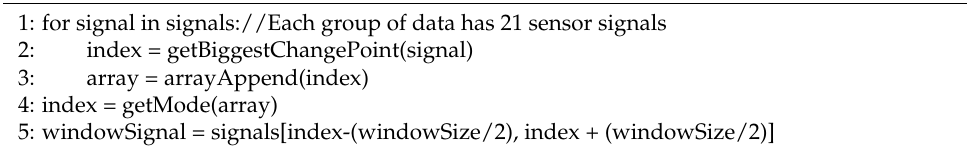
Algorithm 1: Signal Window Extraction